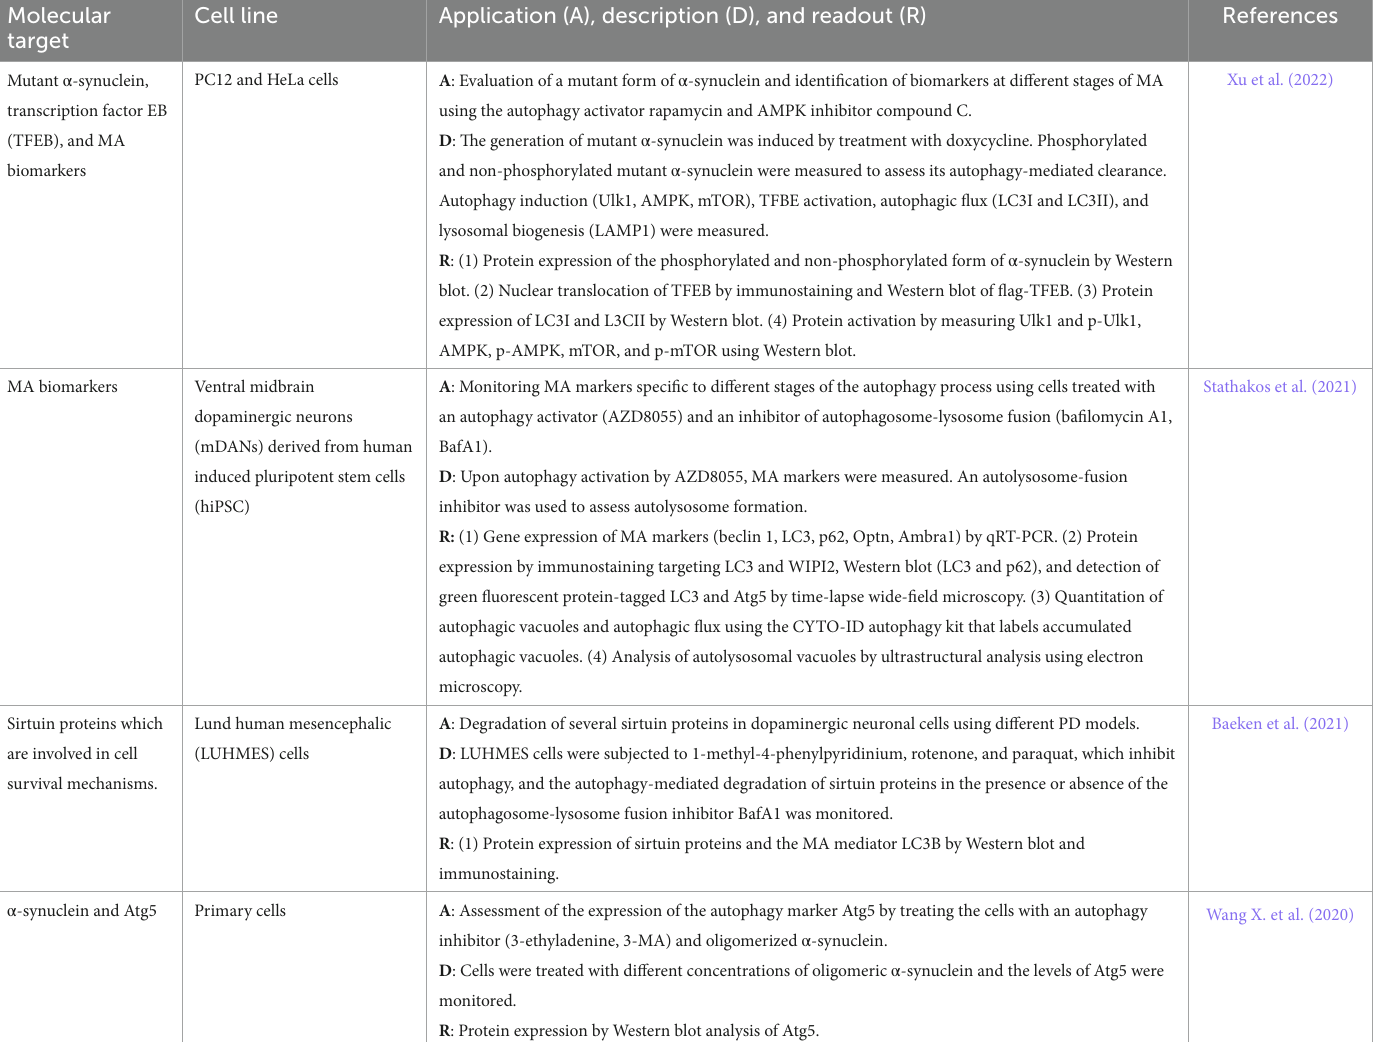
TABLE 1 In vitro autophagy methods in Parkinson’s disease